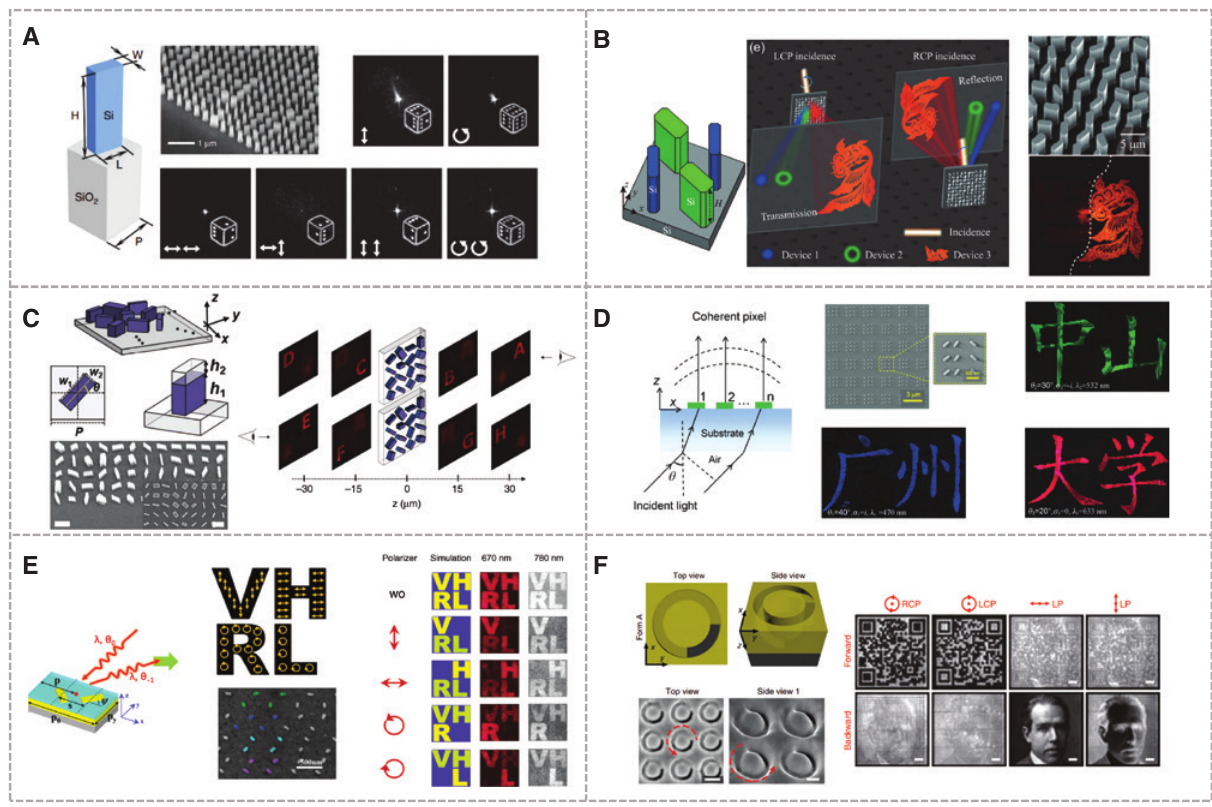
Figure 5: Recent advances on the metasurface-based holography. Each figure is arranged in order of schematic diagram of the proposed structure, SEM image, and experimental result. (A) Multichannel vectorial holographic image and encryption [52]. Regarding the experimental result, the upper two images are captured images varying incident polarizations with no polarizer at the output terminal. Lower four images are captured with polarizer: the left indications are incident polarization, and the right indicates the filter used before measurement. (B) Simultaneous circular asymmetric transmission and wavefront shaping by dielectric metasurfaces [53]. The left figure shows the unit cell structure. (C) Bifacial metasurface for independent phase control on transmission and reflection spaces [54]. The right figure shows the generated holographic image that is differently reproduced by viewing direction. (D) Coherent pixel design of metasurfaces for multidimensional optical control of multiple printing- image switching and encoding [56]. Right three resultant images are obtained by different wavelength, polarization, and incident angle. (E) Diatomic metasurface for vectorial holography [57]. The top middle figure is the desired vectorial holographic image that possesses intensity and polarization information as well. The lower image is the SEM image for the sample. The right figures are measured images, which shows a great match with the simulation results. (F) Plasmonic helical nanoapertures for 3D Janus polarization-encoded image [58]. The right figures are measured images from different illuminated directions with distinct